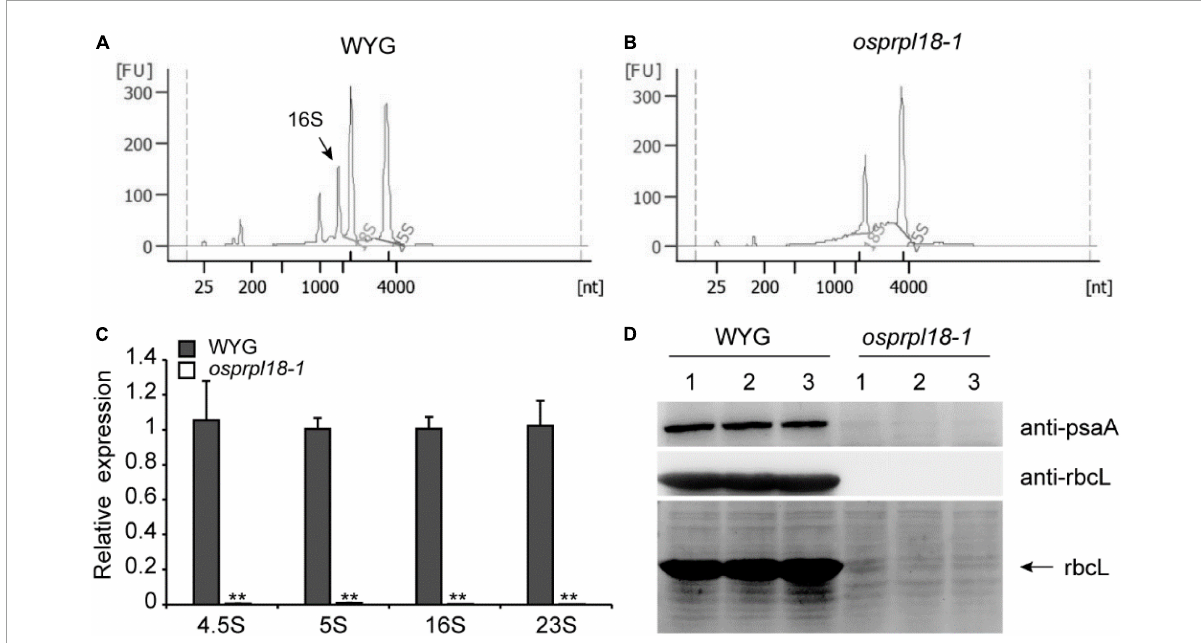
FIGURE6 Comparison of the expression level of plastid rRNA and plastid-encoded protein rbcL in the seedling shoots of WYG and osprpl18-1 mutant. rRNA analysis of WYG (A) and osprpl18-1 mutant (B) with an Agilent 2,100 bioanalyzer. (C) qRT-PCR analysis of the transcripts level of plastid rRNA. UBQ served as the internal control. Gene expression values are presented relative to WYG levels (set as 1). Data represent means ± SD from three biological replicates (** P < 0.01; Student’s t -test). (D) Western blot analyses of the expression of rbcL and psaA. Immunoblotting was performed with specific antibodies, anti-rbcL and anti-psaA (Beijing Protein Innovation Co., Ltd, AbP80037-A-SE, AbP80033-A-SE), respectively (upper panels). The coomassie blue stained gel was used as a loading control (lower panel). For each genotype, three independent biological samples were